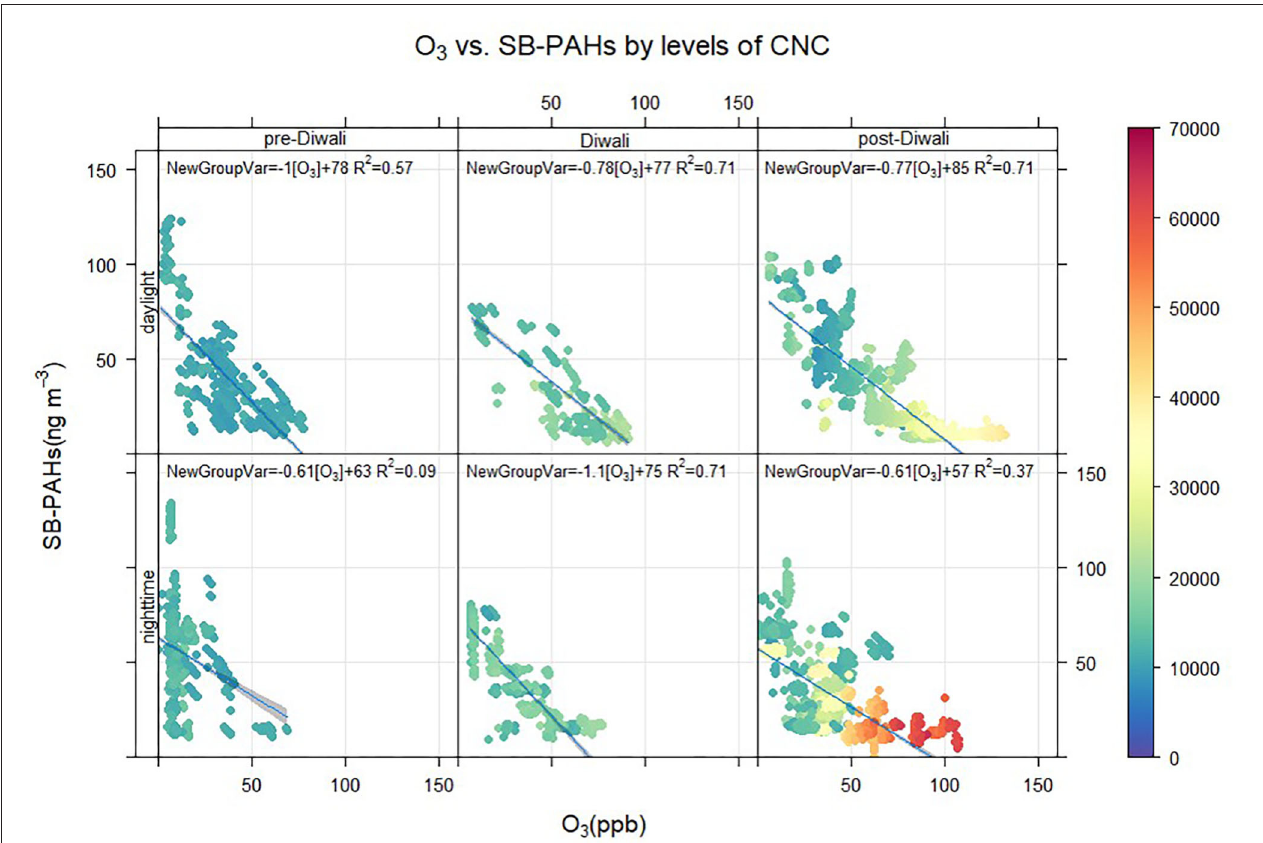
FIGURE 6 | Linear regression analyses ( p < 0.05, exception being on pre-Diwali and post-Diwali nighttime when p > 0.05) of O 3 (X-axis, in ppb) vs. SB-PAHs (Y-axis, in ng m − 3 ) by levels of CPC-based particle’s number concentration (CNC, Z-axis in cm − 3 shown on a scale at the right side of the plot) during pre-Diwali, Diwali, and post-Diwali periods for both daylight and nighttime hours.